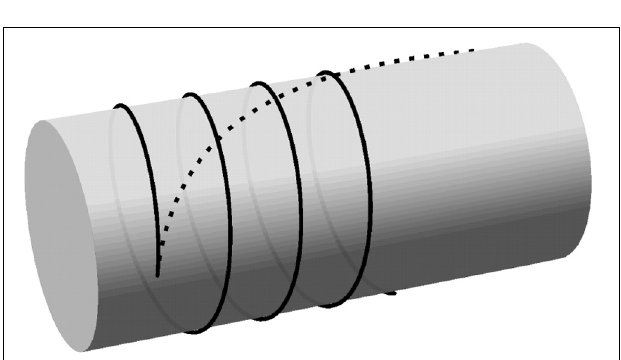
FIGURE 4 | Curvature-minimizing trajectories on a cylinder. Trajectories resulting from local curvature minimization (solid line) and global curvature minimization (dashed line) are initiated from a single nucleation point with an initial opening angle of 5.7 ◦ from the transverse direction. The curve for the global energy minimization has a total length of 4 . 5 times the cylinder radius. (The length is not relevant for the helical solution resulting from local curvature